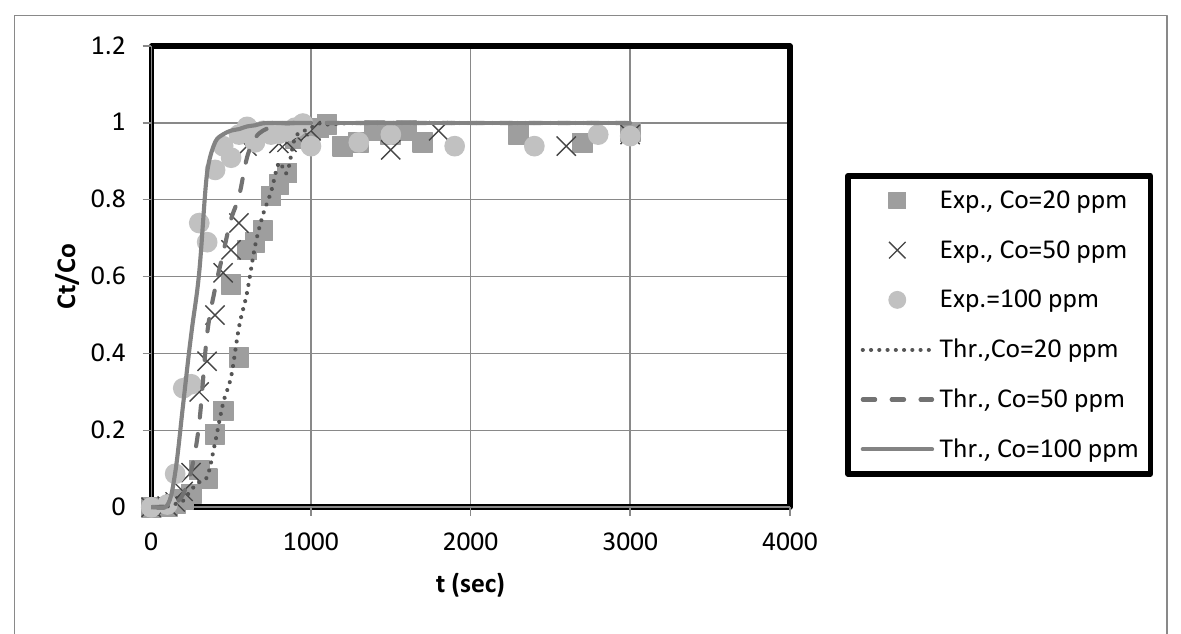
Figure 12. Axial pore di ff usion model fi t of the fi xed-bed breakthrough curve for copper at di ff erent initial solution concentrations. Conditions: h = 0.1 m, us = 0.00473 m/s, kf = 0.000173 m/s, Dp = 2 × 10 − 9 , Dax = 3.53 × 10 − 6 m 2 /s, eb = 0.42, r = 0.000175.